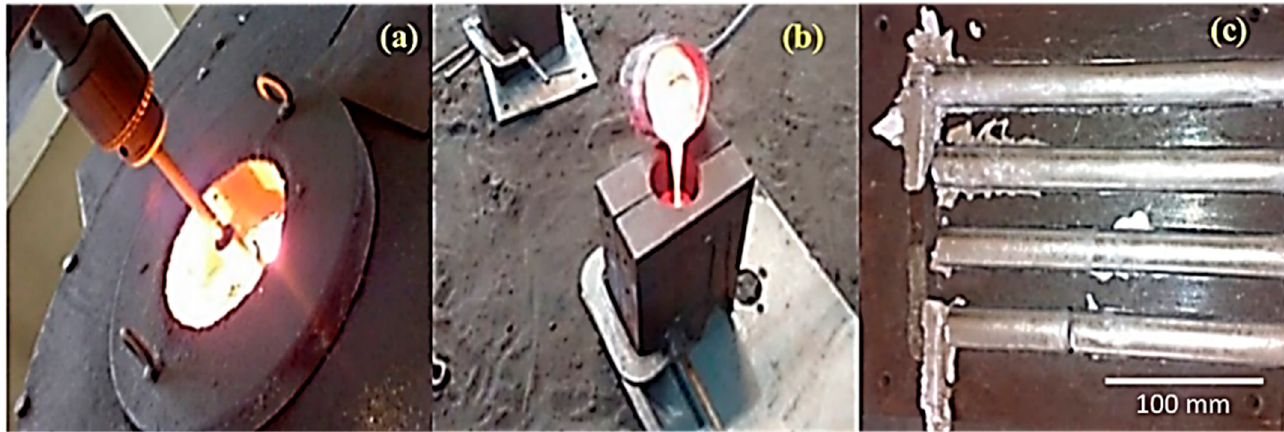
Figure 3. ( a ) Stir casting; ( b ) pouring of molten metal into die; ( c ) cast specimens. Table 5. Experimental conditions for different